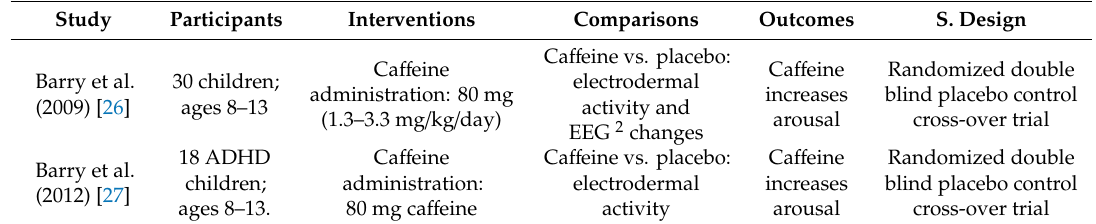
Table 4. Description of analyzed studies on arousal, according to the PICOS 1 method. Study Participants Comparisons